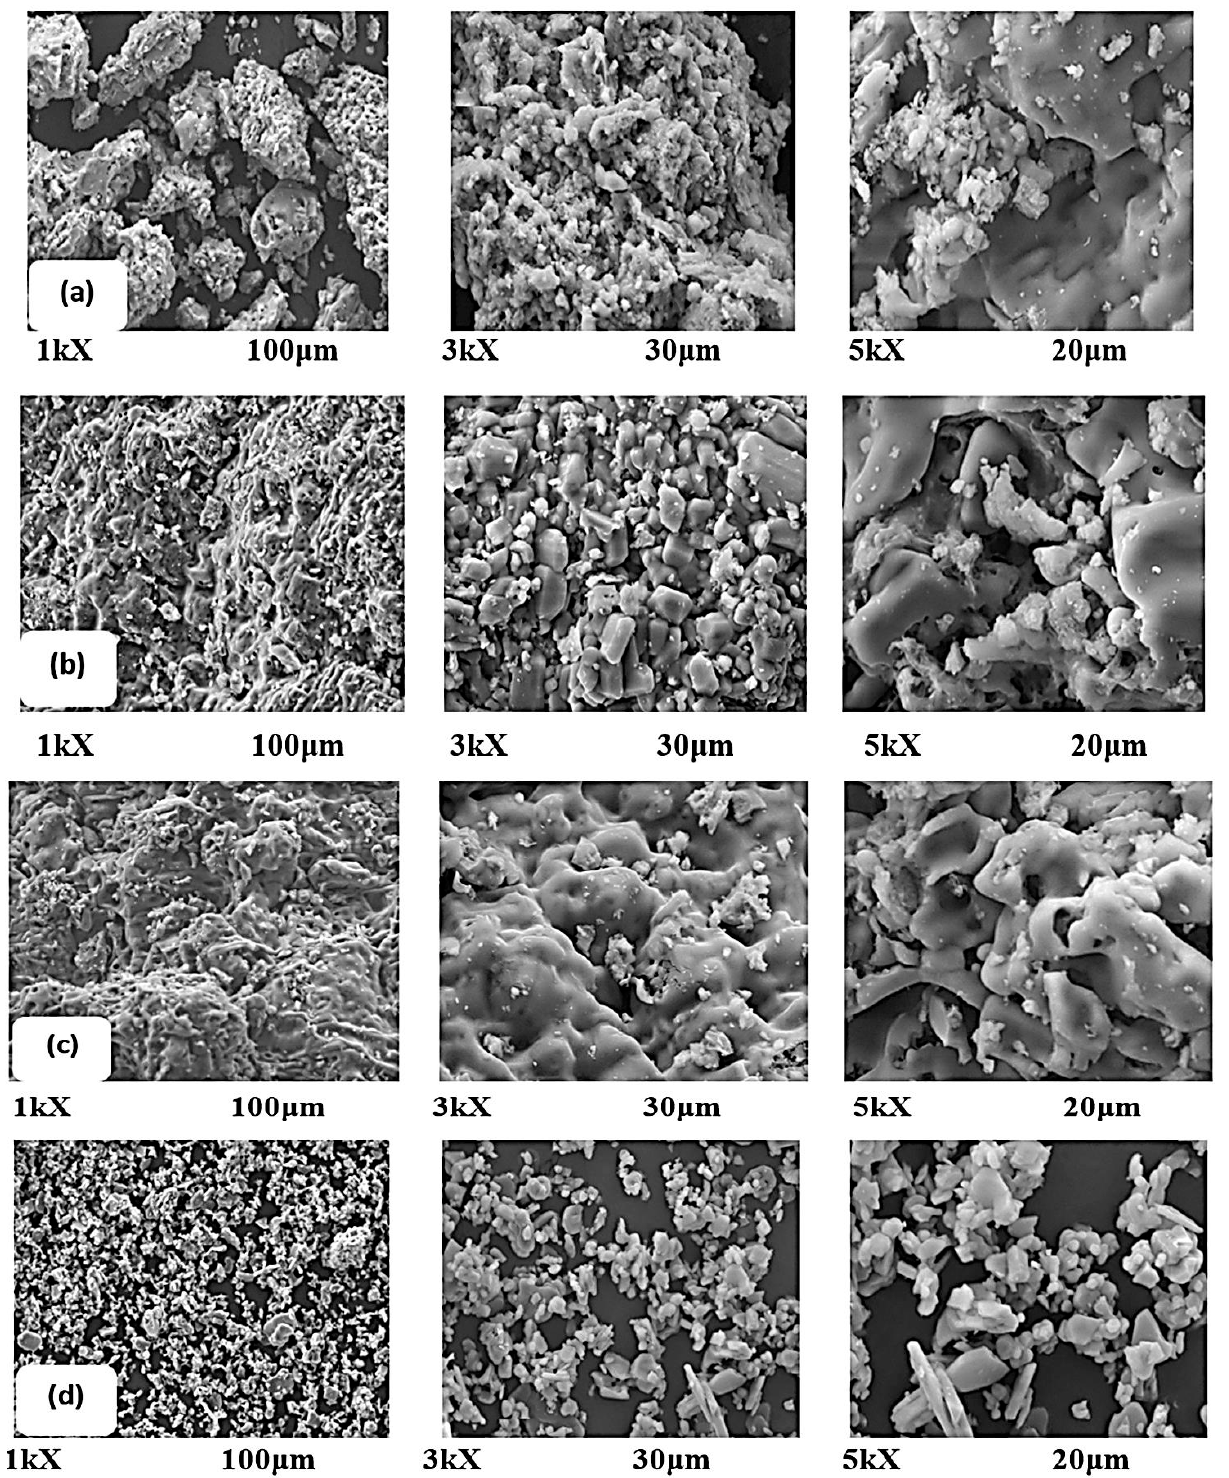
Figure 3. SEM micrographs comparing the effect of reaction times on synthesis of